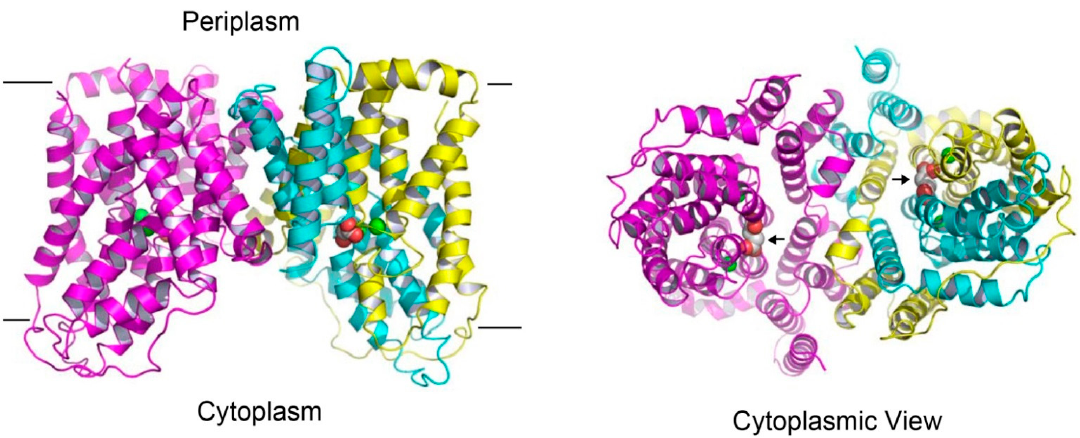
Figure 3. Structure of the succinate-bound VcINDY. Structure of dimeric VcINDY, as viewed from the membrane bilayer ( left panel ). VcINDY is shown in ribbon rendition, the N (amino acids 18-231) and C (amino acids 232-462) domains in one protomer are colored cyan and yellow, respectively, whereas the other protomer is colored magenta. Na + ions (green) and succinate are drawn as spheres. The cytoplasmic view of the VcINDY structure ( right panel ), highlighting the solvent-accessible succinate (black arrows) and buried Na + ions. As such, the crystal structure captures the transporter in the inward-open state. Unless noted otherwise, structural analysis in this review was performed by using the program O and figure was prepared by using the software PyMOL.